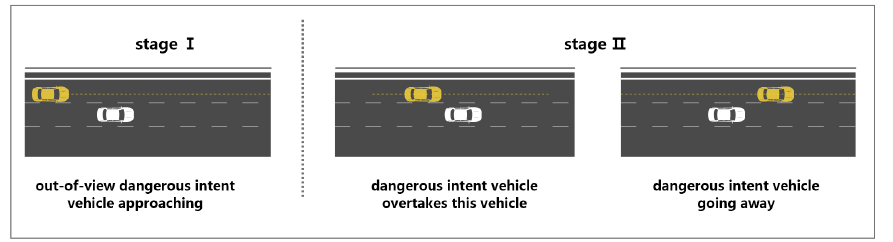
Figure 1. Driving scenario where a dangerous intent vehicle is approaching and overtaking the ego